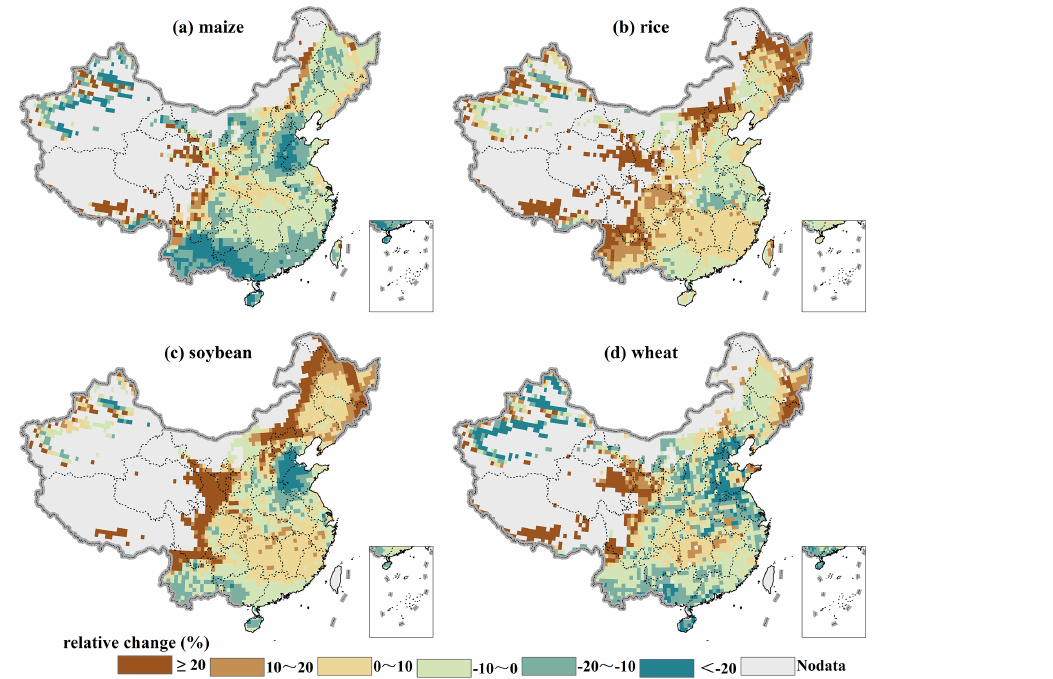
Figure 8. The MM of the relative change in the simulated yield of maize (a) , rice (b) , soybean (c) and wheat (d) with the CO 2 effect at the end of the 21st century (2070–2099) compared with the simulated yield in the historical period (1981–2010).